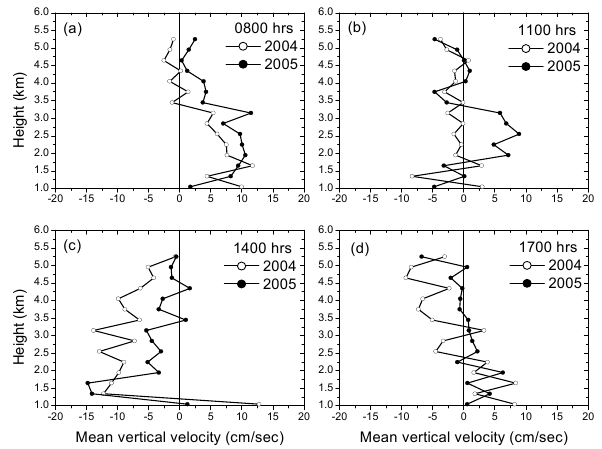
Fig. 5. Vertical distributions of Wind Profiler-derived monthly mean vertical velocity (cm/s) at four observational hours, (a) 08:00h, (b) 11:00h, (c) 14:00h, and (d) 17:00h IST, in March 2004 and